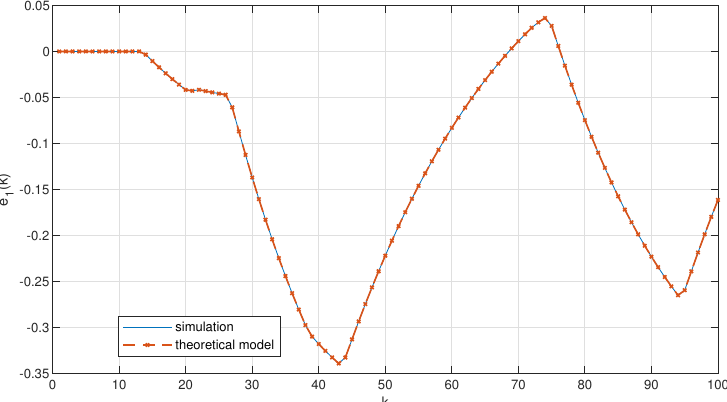
Figure 4. Distance error between leader and the first follower for multiple random